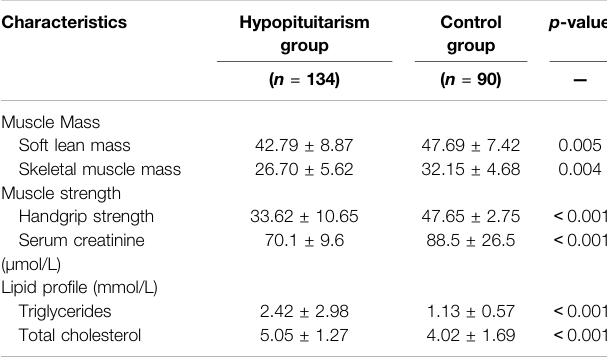
TABLE 5 | Anthropometric and biochemical characteristics of the study population.